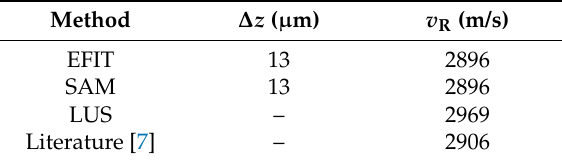
Table 1. Rayleigh wave velocity results for an aluminium sample.